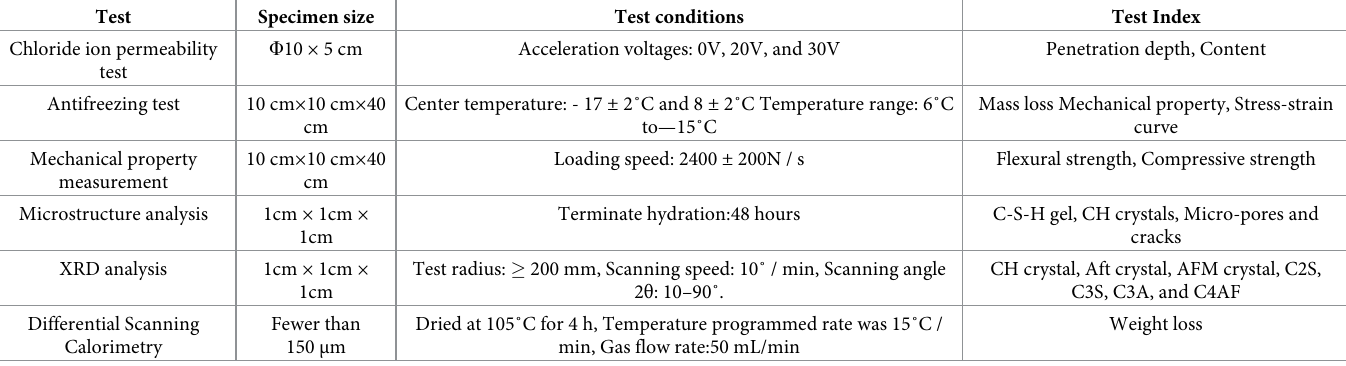
Table 4. Experimental